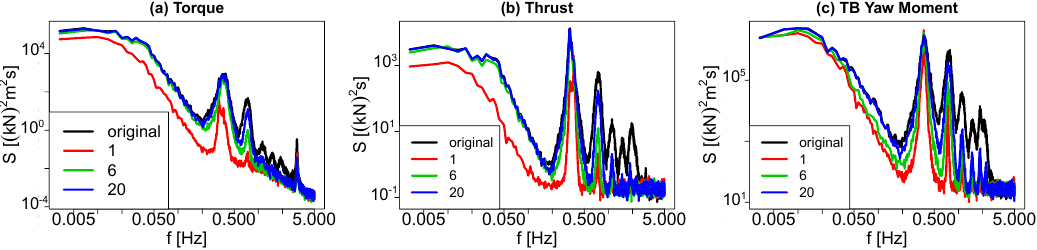
Figure 9. Time series of the different loads for original LES and a truncated POD including N = 6 modes. Here and in the following figures TB yaw moment is used as an abbreviation for tower base yaw moment.